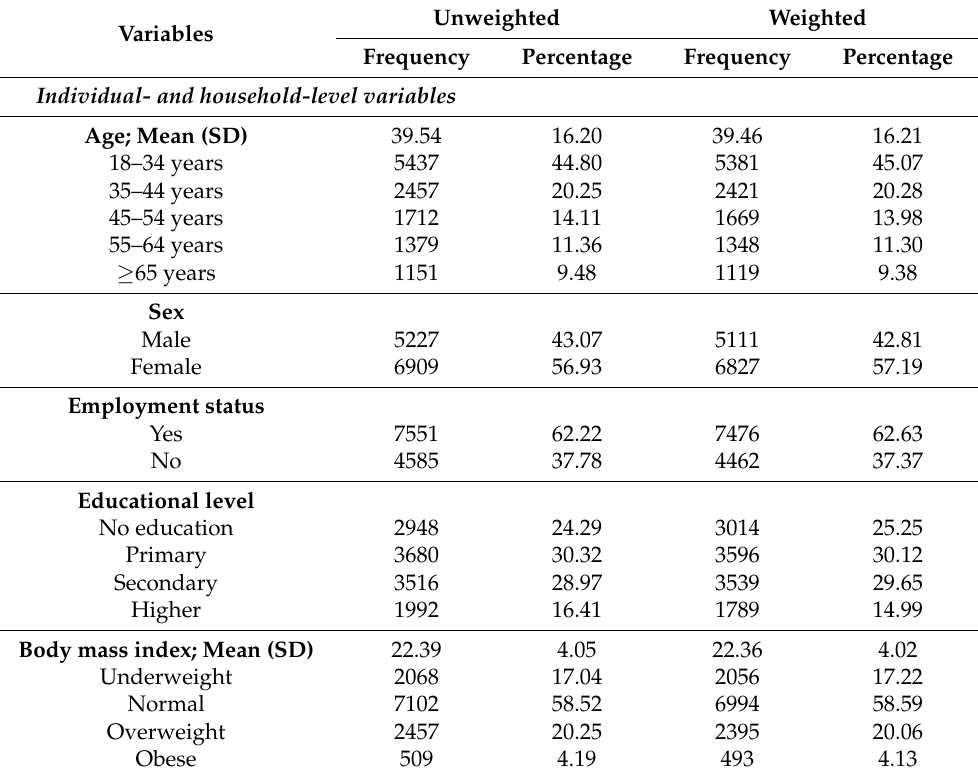
Table 1. Background characteristics of study participants ( n =